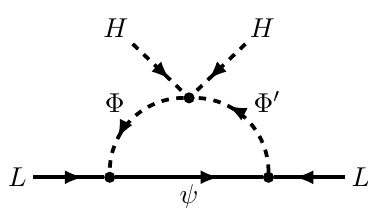
Figure 1 . Diagram generating neutrino masses at the one-loop